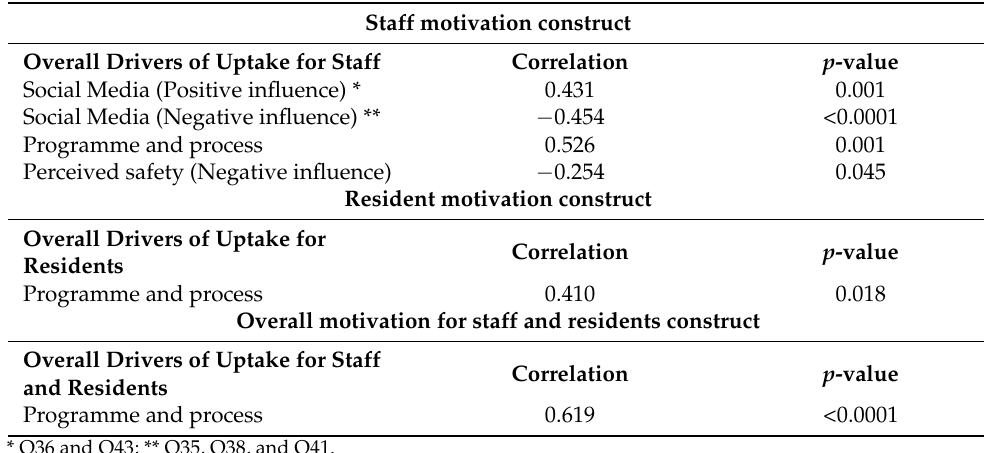
Table 7. Assessment of correlations between staff and residents’ motivation, social media, perceived safety, and programme and